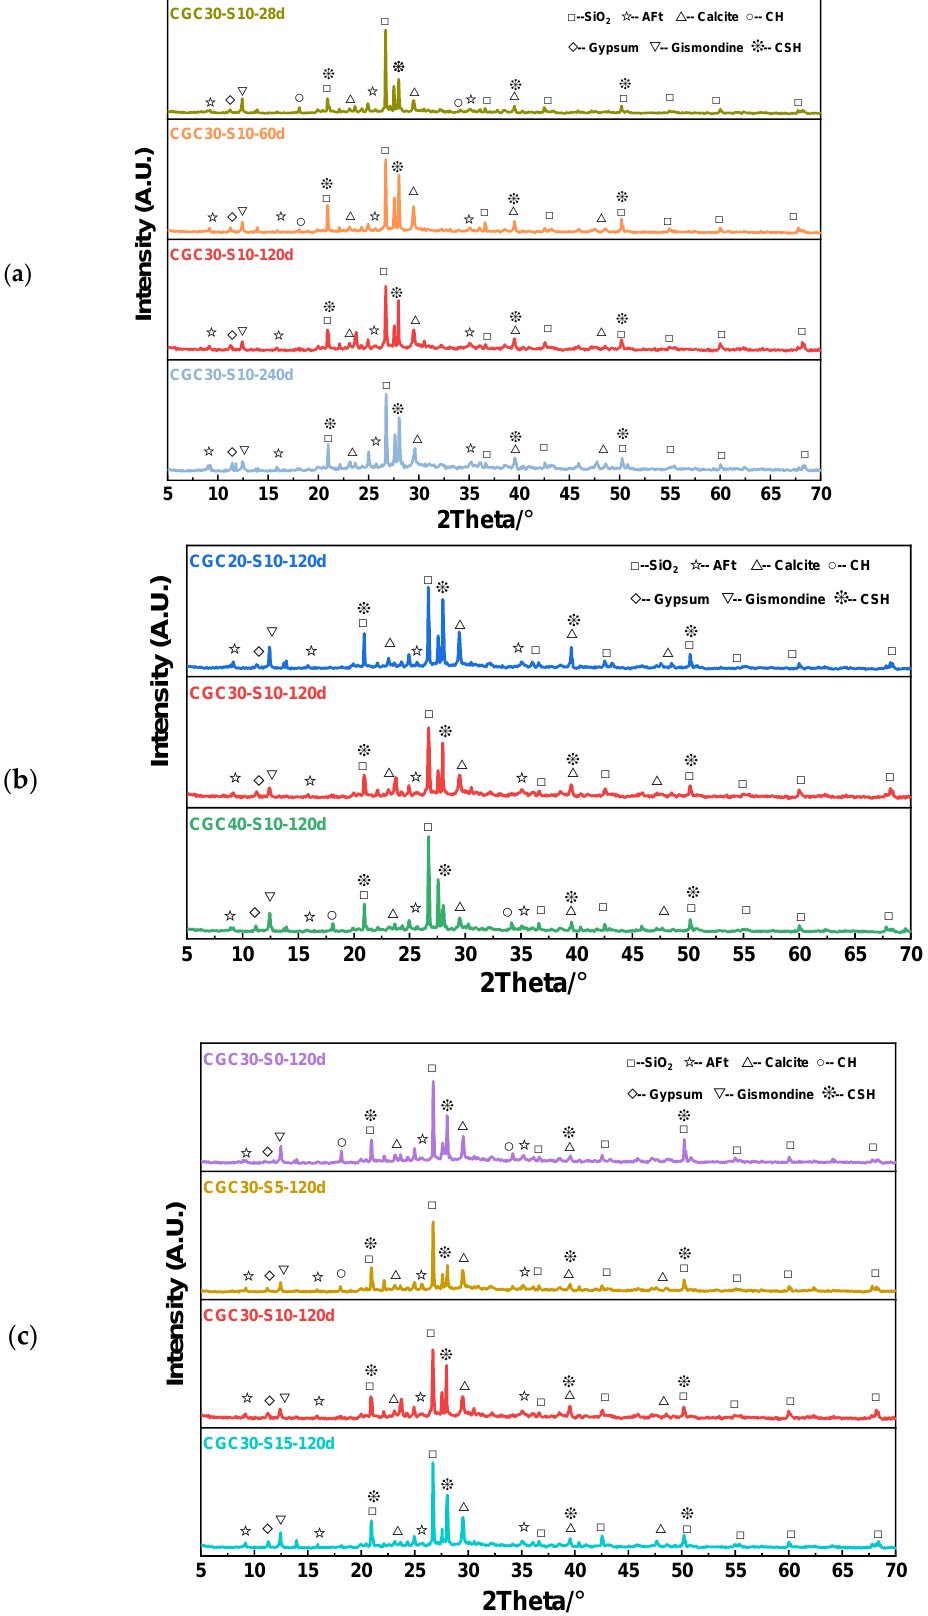
Figure 10. XRD patterns of different sulfate-attacked CGC specimens: ( a ) corrosion time; ( b ) CGC strength grade and ( c ) sulfate concentration.